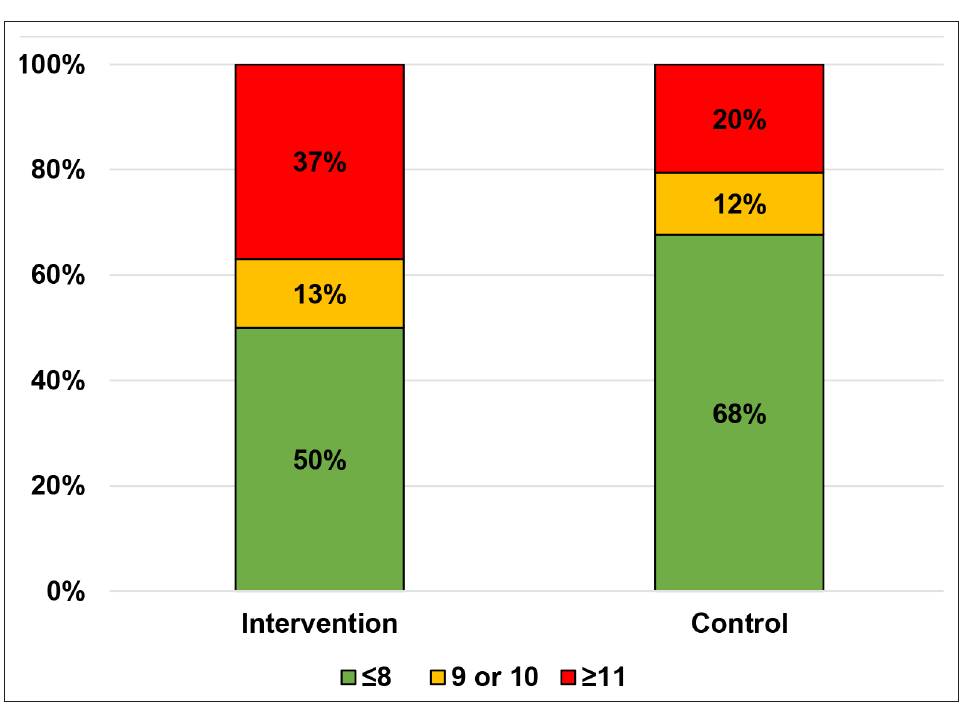
Figure 2 PEDT scores at Week 4 after the consultation, where a score of ≤8 signifies no PE; 9–10 signifies probable PE; and ≥11 signifies PE ( P = 0.24 between